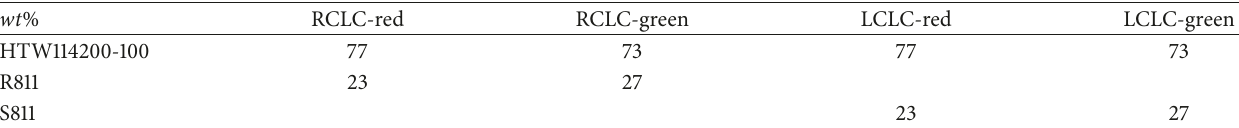
Table 1: Prescription of the refilled right-handed and left-handed CLC (RCLC and LCLC, respectively) materials. The indices of “red” and “green” behind RCLC or LCLC mean that the CLC materials reflect at red and green regions, respectively. wt % RCLC-red RCLC-green LCLC-red LCLC-green HTW114200-100 77 R811 23